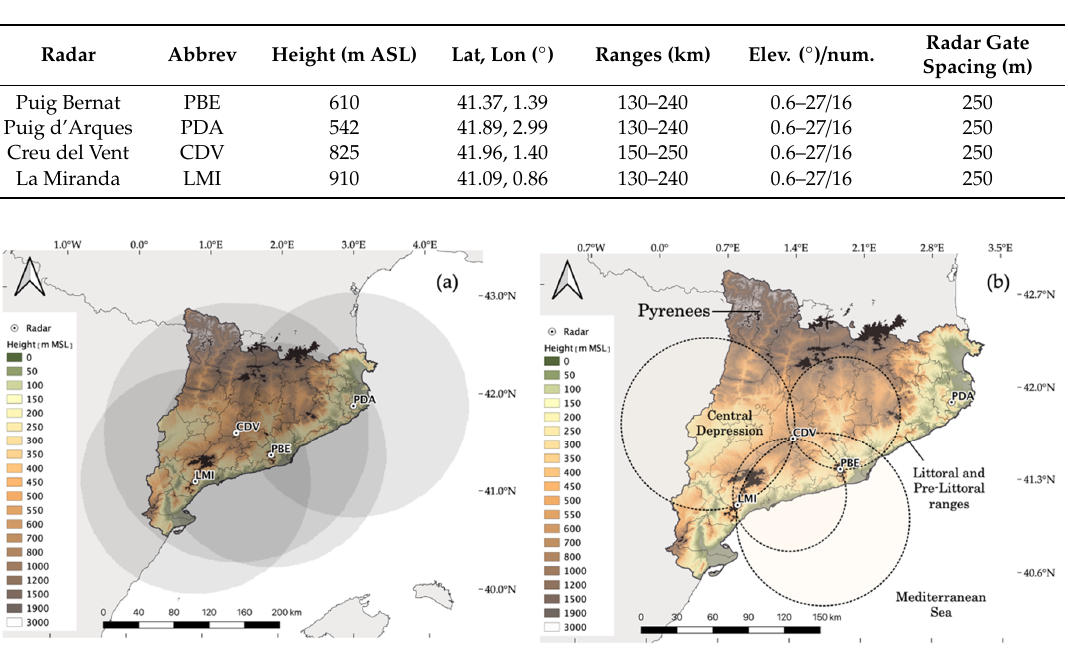
Table 1. Radar site name, abbreviation, height AGL (m), location, operational unambiguous maximum ranges (km) and operational elevation angles ( ◦ ), total number of elevations, and gate spacing (m) of the XRAD.